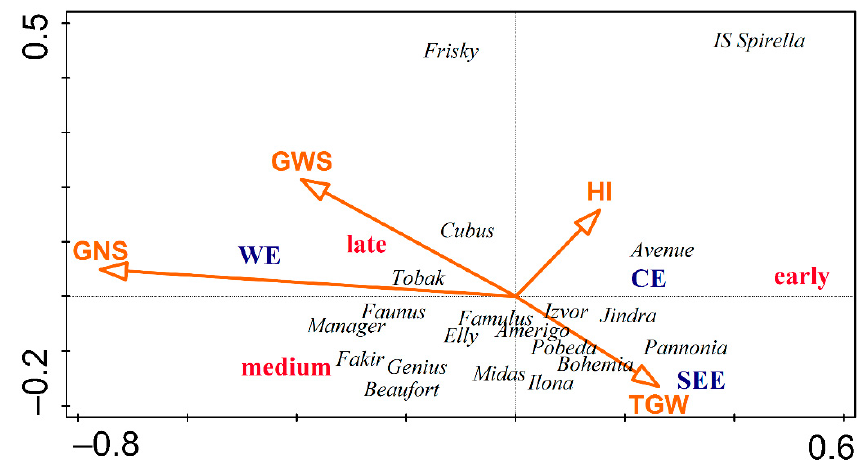
Figure 6. RDA of the responses of winter wheat genotypes to drought stress treatment through an analysis of the relative reductions in (1) GNS, (2) GWS, (3) TGW, and (4) HI via a categorization of the genotypes into groups according to time to maturity (early, medium, late) and site of origin (Central Europe, Western Europe, southeastern Europe).